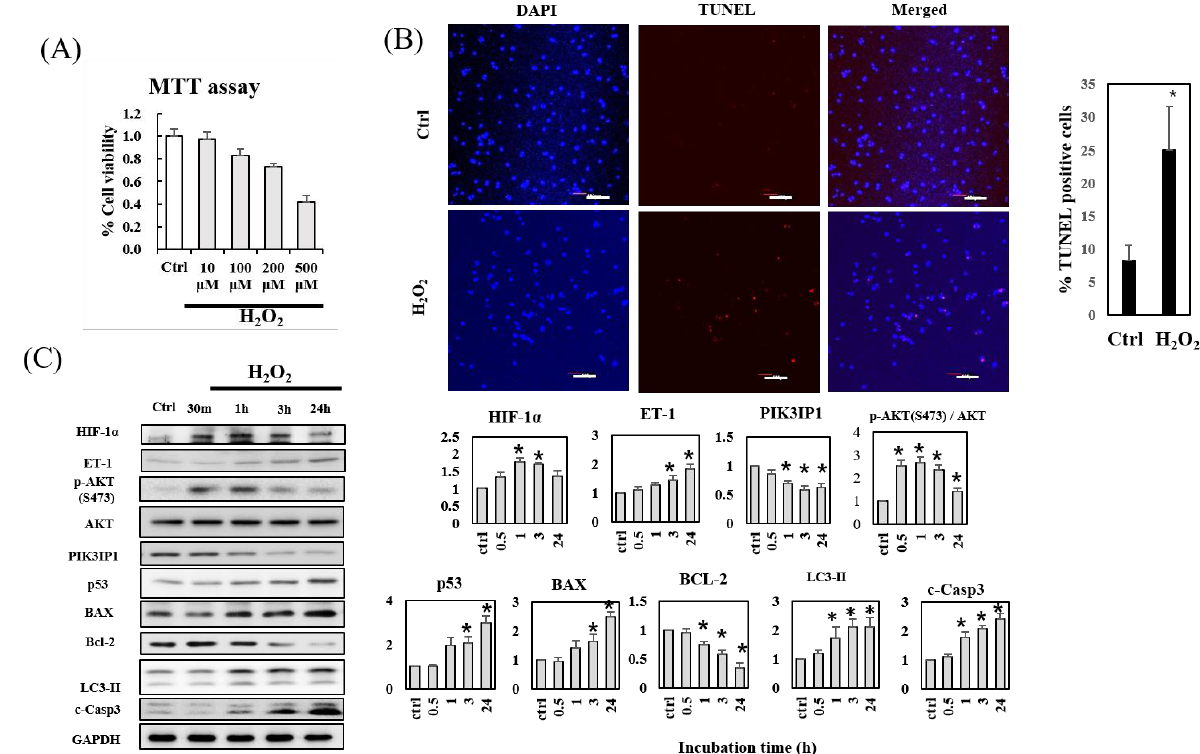
Figure 1. H 2 O 2 -induced apoptosis of H9c2 cardiomyocytes is accompanied by decreased PIK3IP1 and Bcl2 expression, but increased HIF-1 α , ET-1, p53, BAX, LC3-II, and cleaved caspase-3